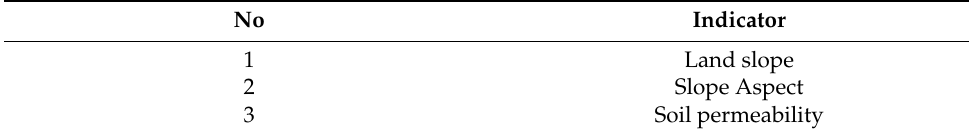
Table 3. Indicators used in the calculation of Hazard Index (HI).